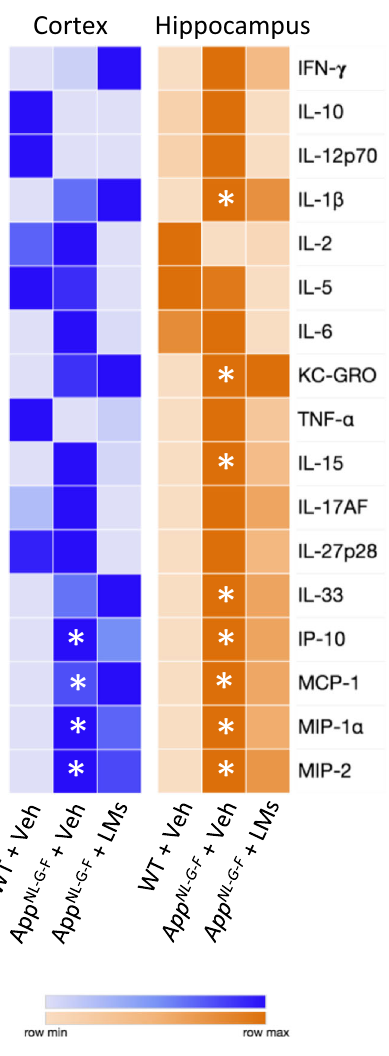
Fig. 5 Cytokines and chemokines are altered in the brain of App NL-G-F mice. Cytokines and chemokines were analysed in homogenates of cerebral cortex and hippocampus by multi-immunoassay (Meso Scale v-plex). Rows in the heatmap represent cytokines and chemokines and columns represent treatment groups. The colours represent median of normalized concentration values. n = 5 mice/group. Asterisks denote statistical signi fi cance between wild-type (WT) and App NL-G-F mice given vehicle (Veh) using Kruskal-Wallis with Dunn ’ s post hoc test. IFN- γ interferon- γ , IL interleukin, IP-10 interferon- γ -induced protein 10, KC-GRO keratinocyte chemoattractant/human growth-regulated oncogene, MCP-1 monocyte chemoattractant protein, MIP macrophage in fl ammatory protein, TNF- α tumour necrosis factor- α